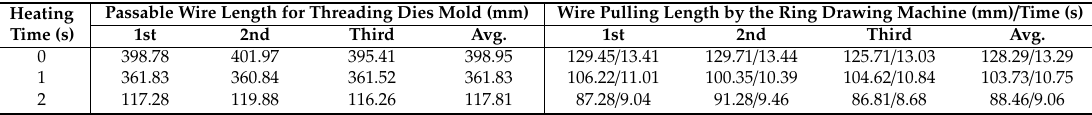
Table 16. Results based on wire pulling speed: k5(9.65 mm / s).